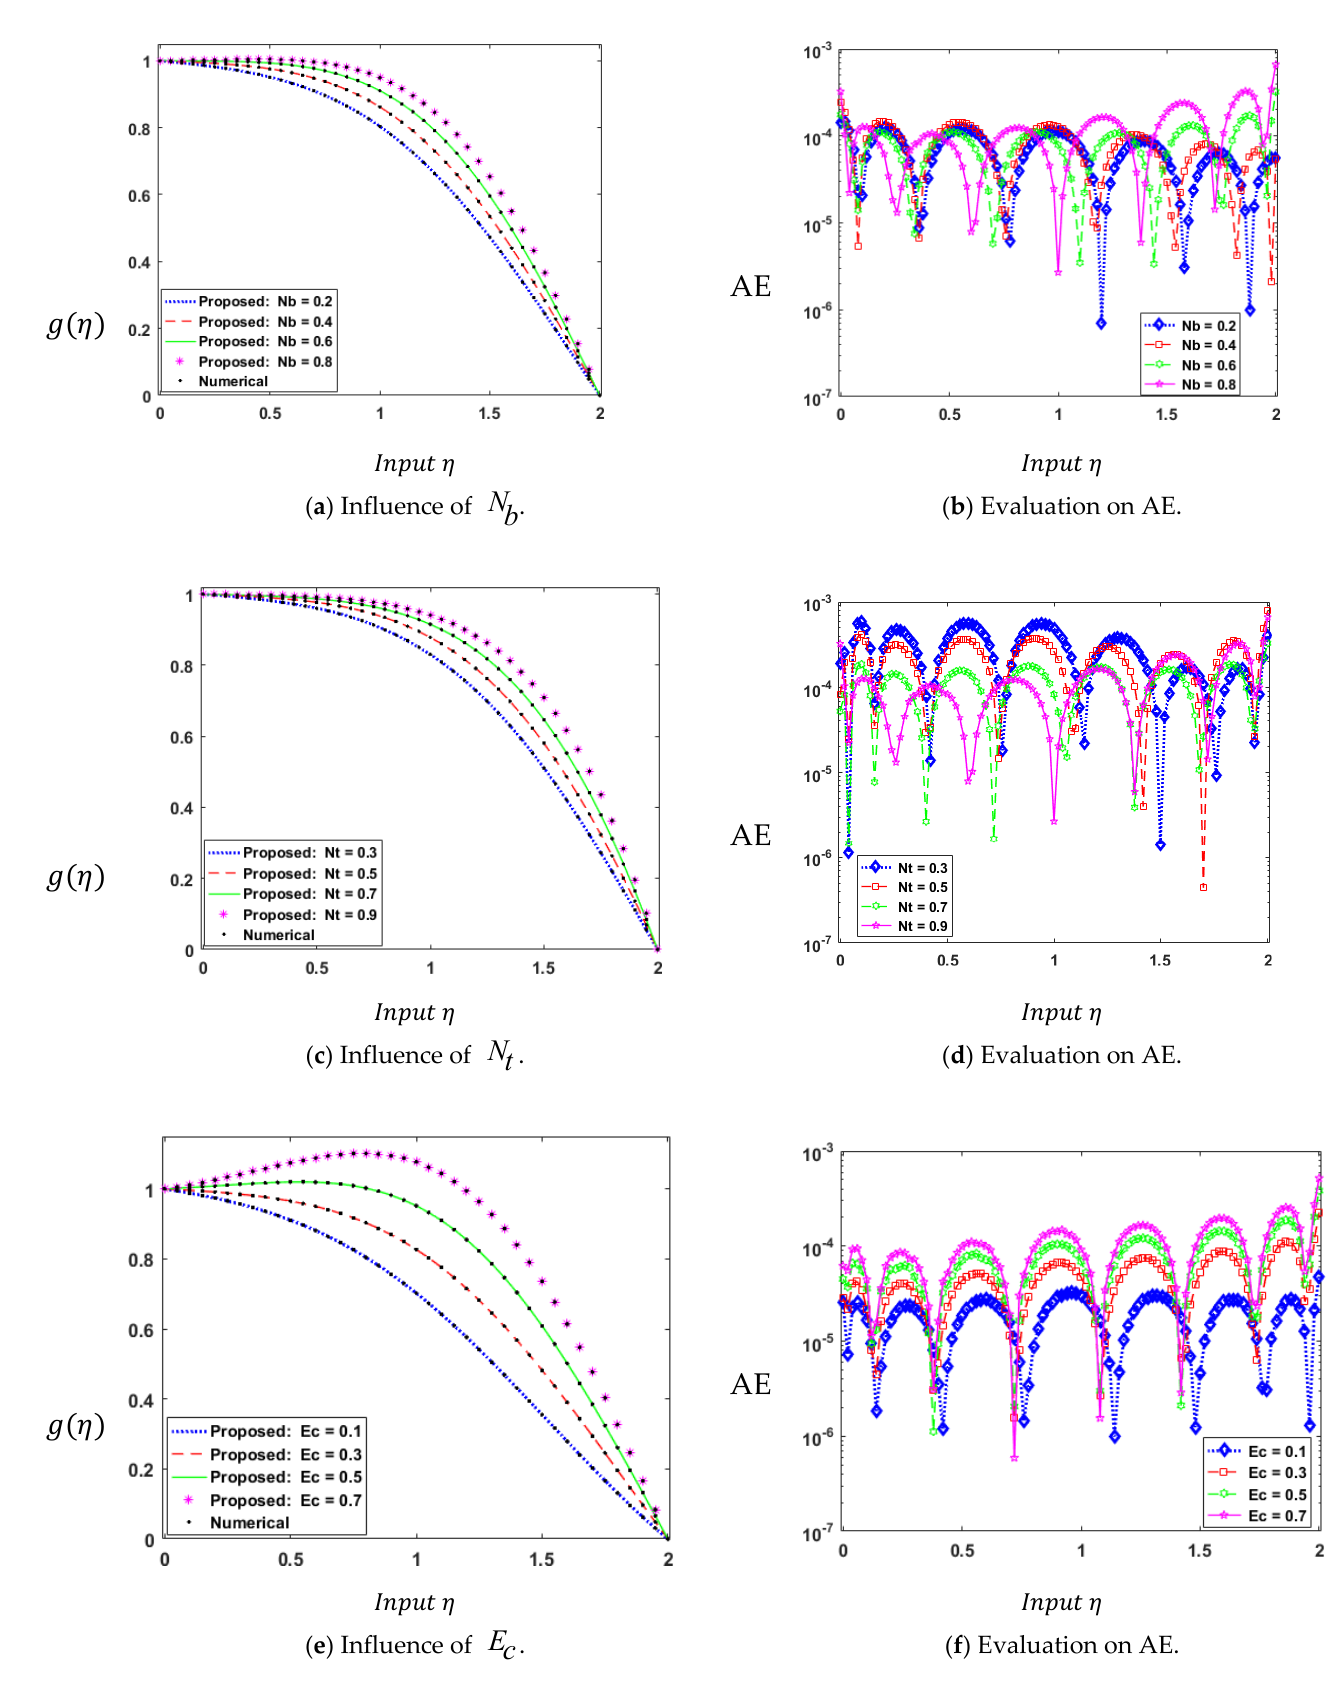
Figure 15. Evaluation of suggested TLMB-NN with outcomes of reference dataset for Scenarios 4–6 of HTM-BFN model with MHD.